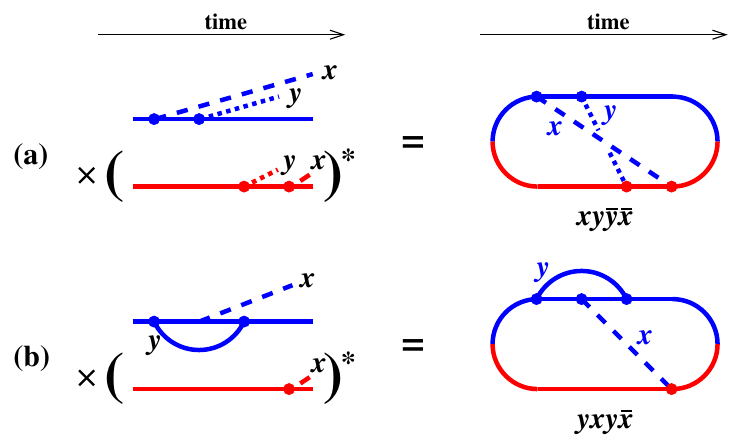
Figure 1 . Two examples (previously computed [13, 19]) of interference contributions to the rates for (a) double splitting g → ggg and (b) virtual corrections to g → gg (where y is virtual and must be integrated over). All lines in these diagrams represent high-energy gluons which implicitly and repeatedly interact with the medium (not shown). The left side above depicts contributions to the rate, obtained by multiplying a contribution to the amplitude (blue) by a contribution to the conjugate amplitude (red), with a particular time-ordering of all the vertices. The right side shows a more compact way of diagrammatically representing the same interference contributions, which is particularly useful for our implementation and extension [13, 19] of Zakharov’s method [8, 9]